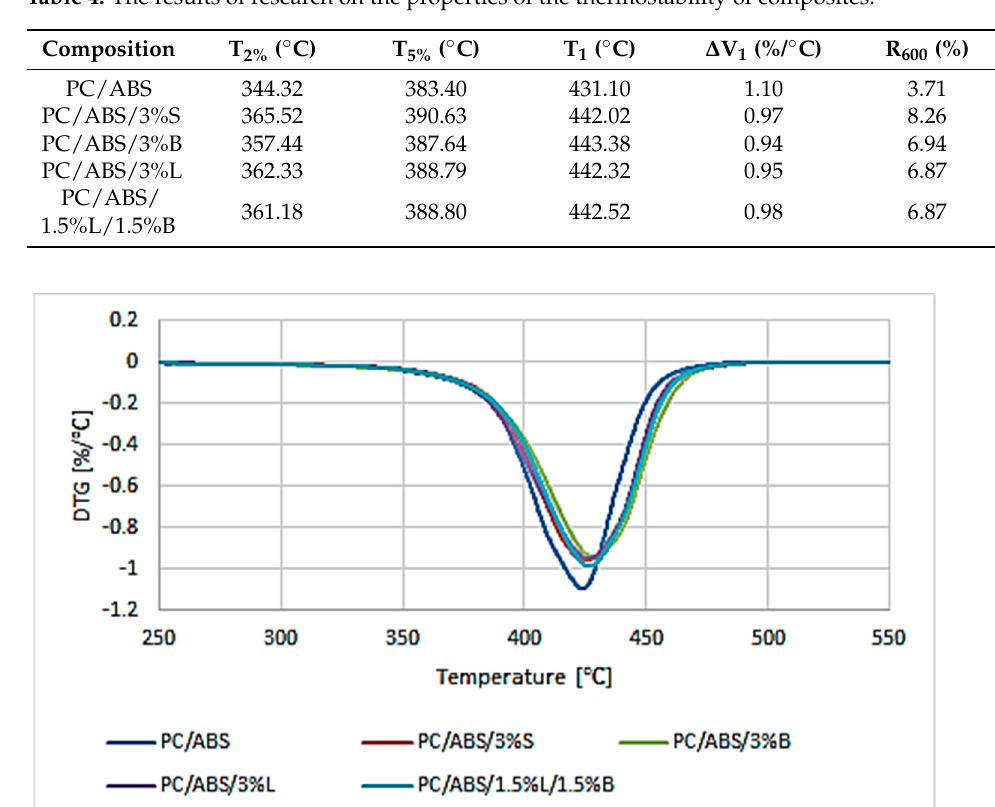
Figure 11. Results of DTG analysis (mass change derivative curve) of PC/ABS and composites based on PC/ABS.